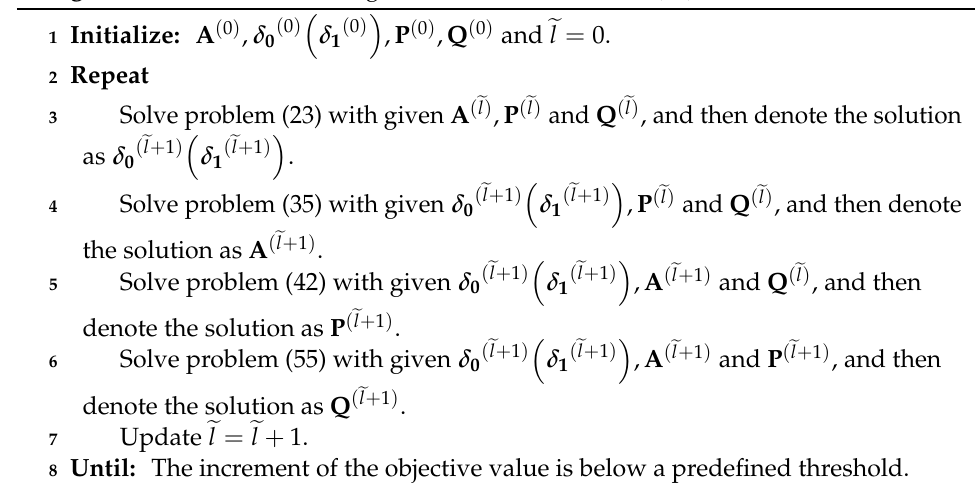
Algorithm 1: The Iterative Algorithm to Solve Problem